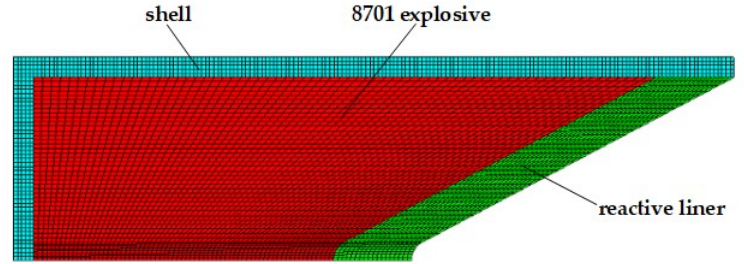
Figure 6. Finite element calculation model of the shaped